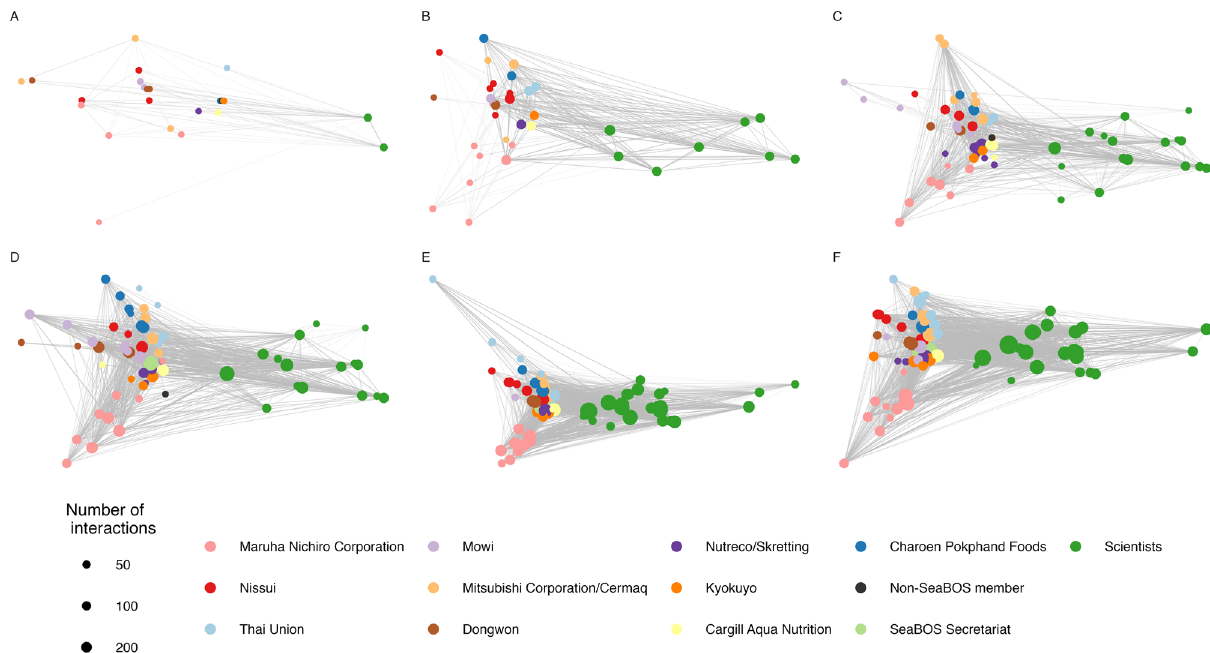
Figure 1. Evolution of connectivity between scientists and SeaBOS companies. (A) Initial regional connectivity, took place during Phase I, when scientists engaged multiple industry actors in individual or regional dialogues in either Japan, Norway or South Korea. (B) Phase II included two keystone dialogues, and resulted in the establishment of a global science-business network. (C) The formation of task forces during Phase III involved strengthened and diversified interactions between multiple scientists and company representatives. (D) Phase IV included a new coordinating function (a formal SeaBOS secretariat), and a set of time bound goals were defined during Phase V (E) . SeaBOS produced tangible results and can be described as having become fully functional during Phase VI (F) . Each node represents one individual and the size of the node corresponds to the sum of all interactions for each time period. The color of the node corresponds to the type of actor engaged in the networks.